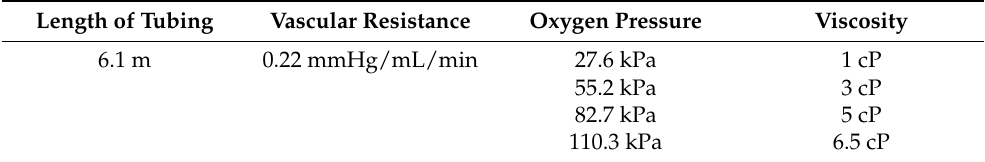
Table 3. Testing Matrix.